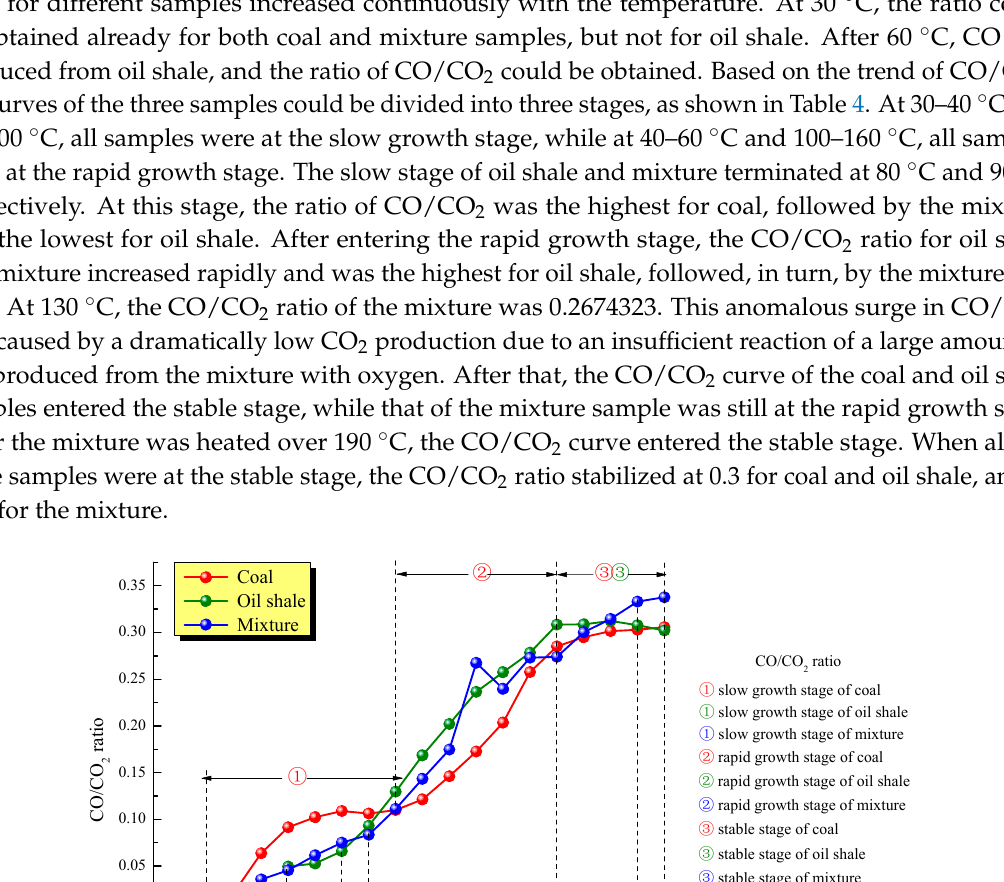
Table 3. Three sample stages with respect to CO concentration.